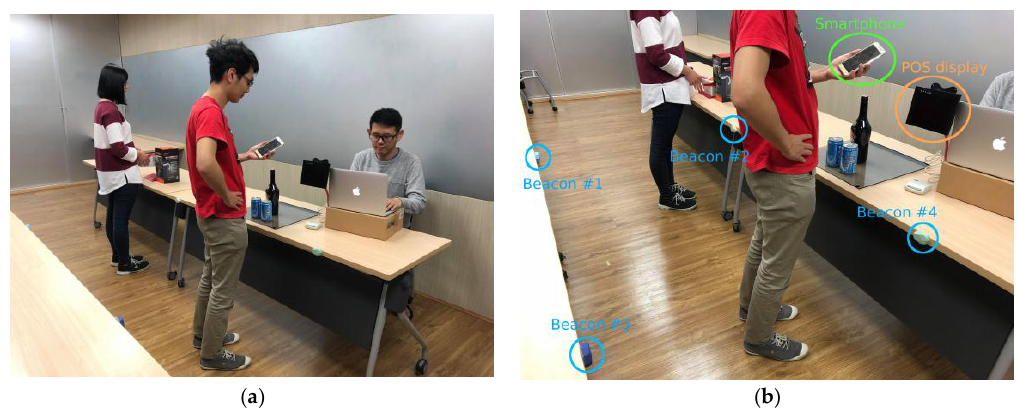
Figure 6. The practical implementation of the proposed mobile payment system: ( a ) four Bluetooth beacon tags are placed at the same height horizontal surface; and ( b ) a closer look on the arrangement of each device.